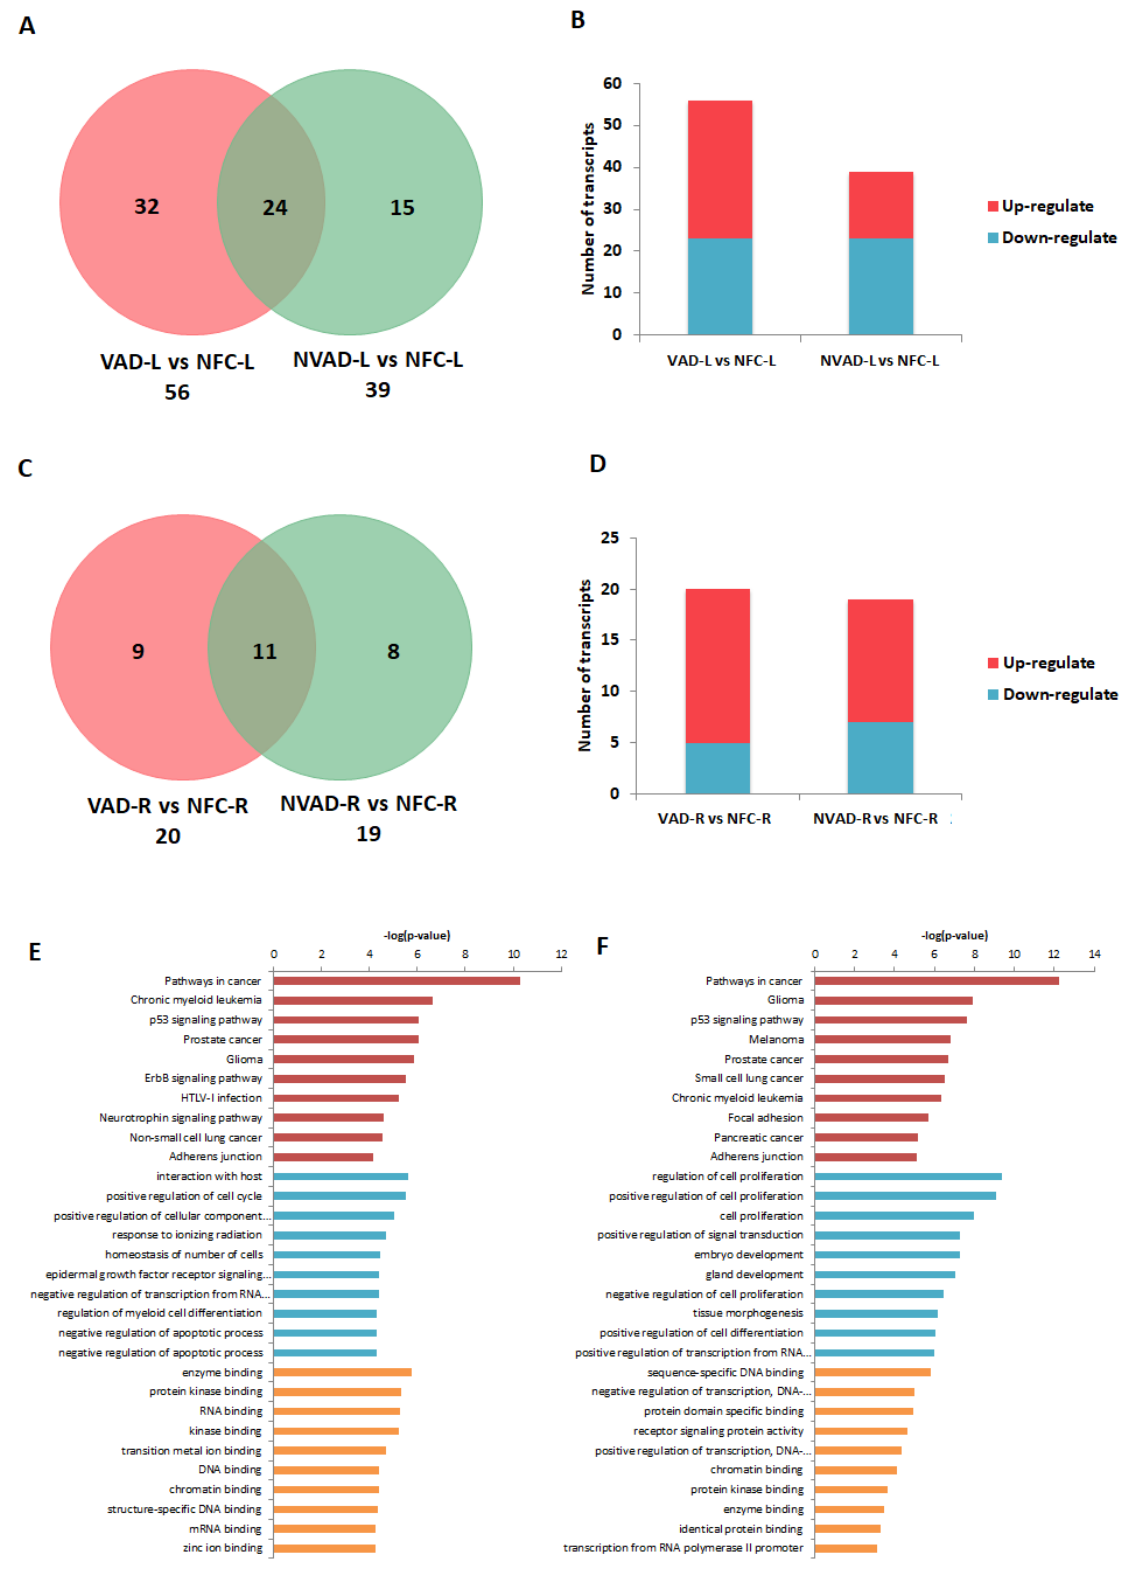
Figure 6. miRNA analysis of left (L) and right (R) ventricles from dilated cardiomyopathy (DCM) hearts with (VAD) and without left ventricle assist device (NVAD), using the non-failing controls (NFC) as reference. Number of significant differentially expressed miRNAs in the ( A ) L ventricle and ( C ) R ventricle of VAD and NVAD groups. ( B ) Number of significantly up- and down-regulated